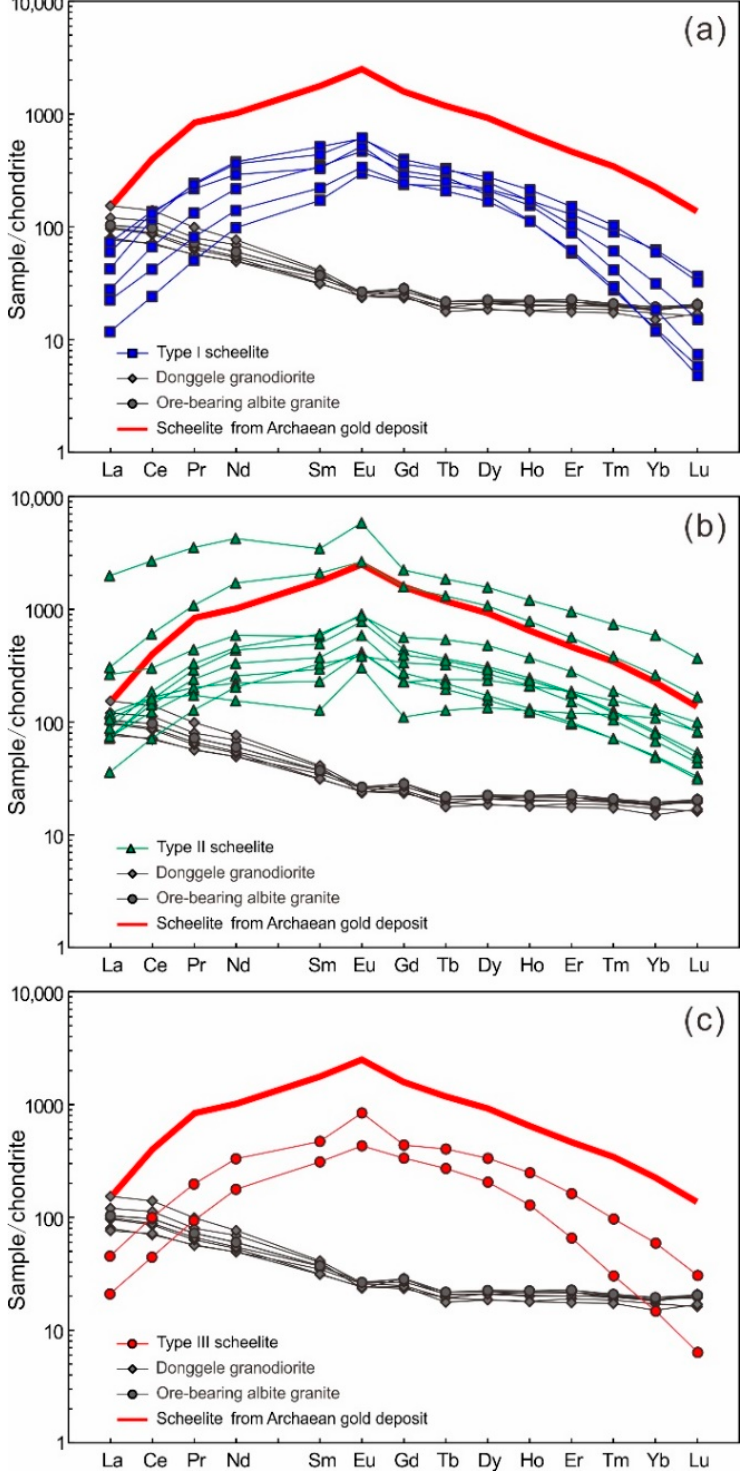
Figure 4. Chondrite-normalized REE patterns of scheelite from the Doranasai gold deposit. ( a – c ): three types of scheelite. Note: Scheelite from Archean gold deposits, Western Australia is adopted from [11]. The data of Donggele granodiorite and ore-bearing albite granite dyke in Doranasai area are cited from [4]. The values of Chondrite are from [44]. Table 1. Contents of major oxides of scheelite samples from the Doranasai gold deposit (wt%).